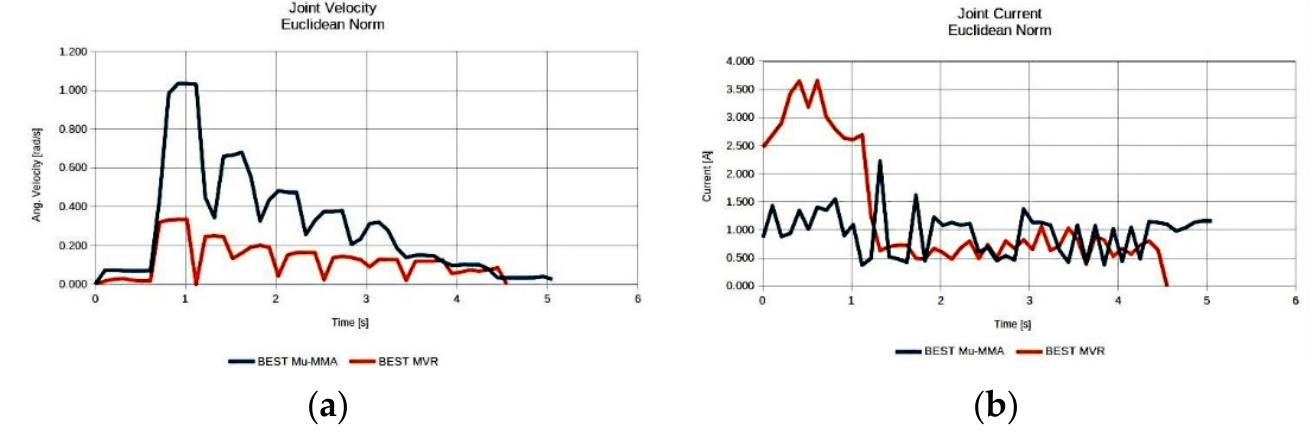
Figure 15. Comparison of the required joint velocities ( a ) and joint current usage ( b ) for the best anatomies under each performance index for Task 2.